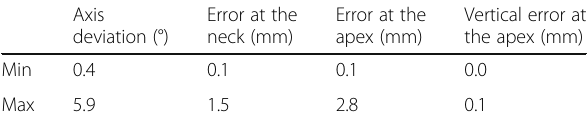
Table 1 Range of various maximum permissible errors as calculated in the present study